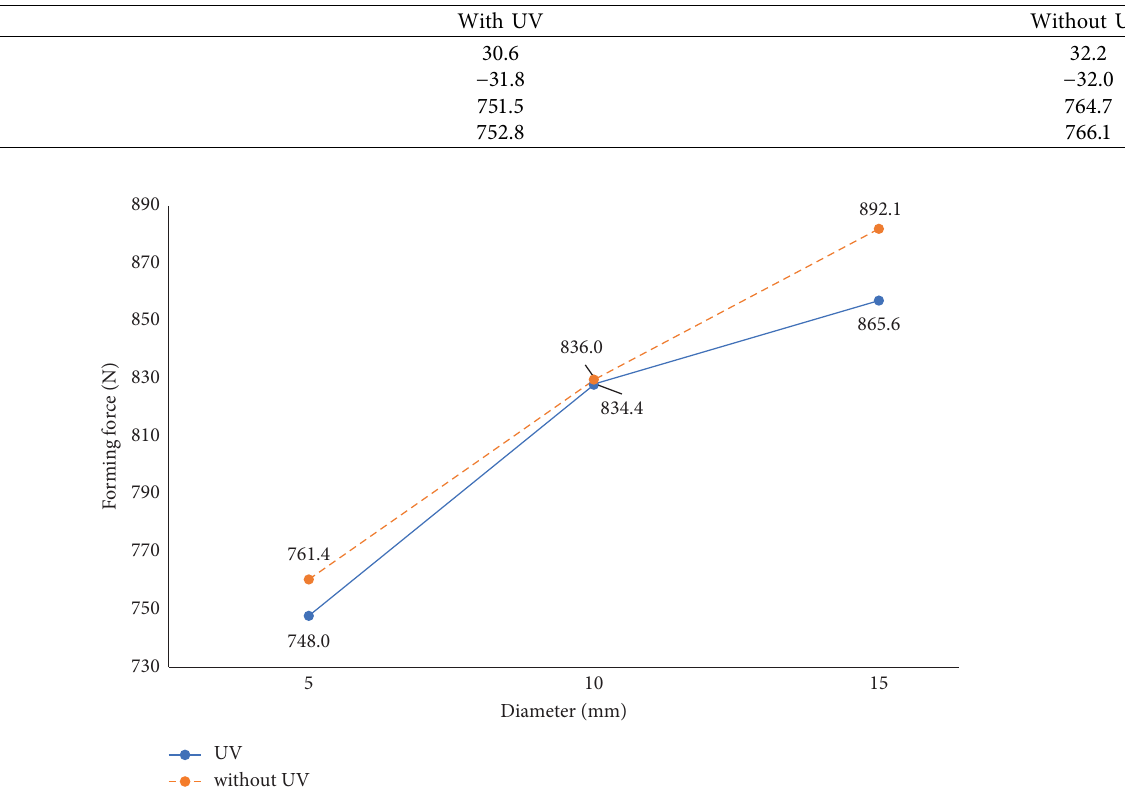
Figure 11: Forming forces with diferent tool